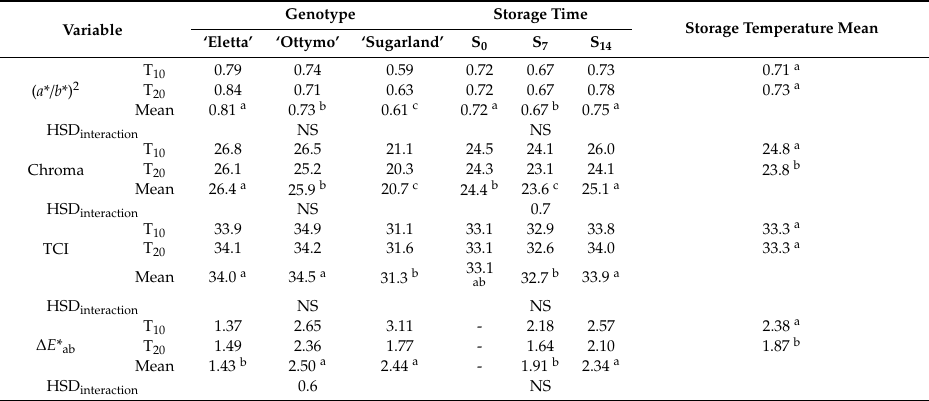
Table 5. Chromatic variables of the epicarp of cherry tomato as a ff ected by the main factors. Genotype Storage Variable